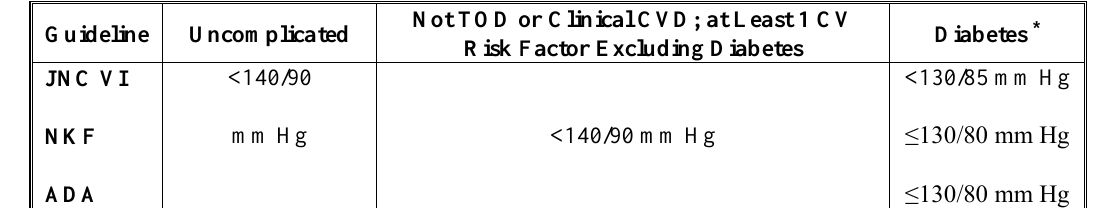
Table 1: Recommended Target BP Goals